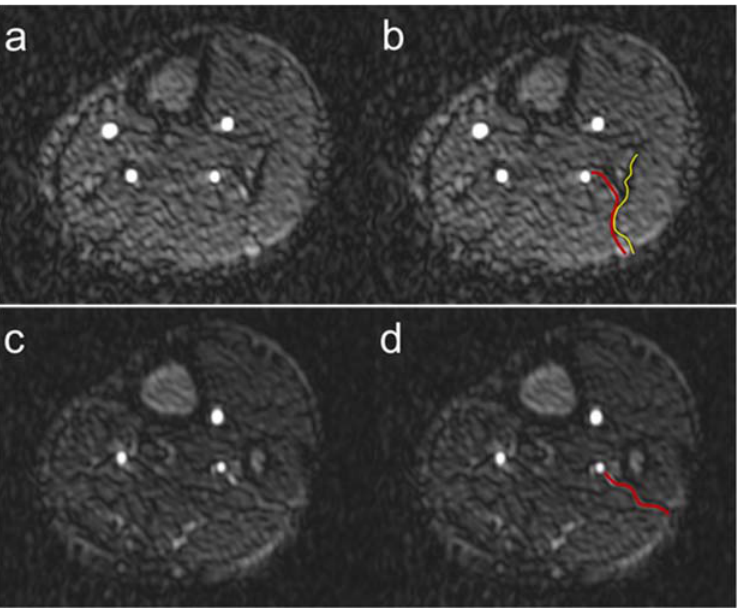
Figure 8. Course of fibular perforators. Exemplary course of a septocutaneous fibular perforator in the posterolateral intermuscular septum ( a ) in a 62 ‐ year ‐ old male patient. The red line in panel ( b ) shows the course of the perforator, the yellow line the posterolateral intermuscular septum. Exemplary course of a septocutaneous fibular perforator to the cutis ( c ) in a 49 ‐ year ‐ old male patient. The red line in panel ( d ) shows the course of the perforator to the cutaneous level.